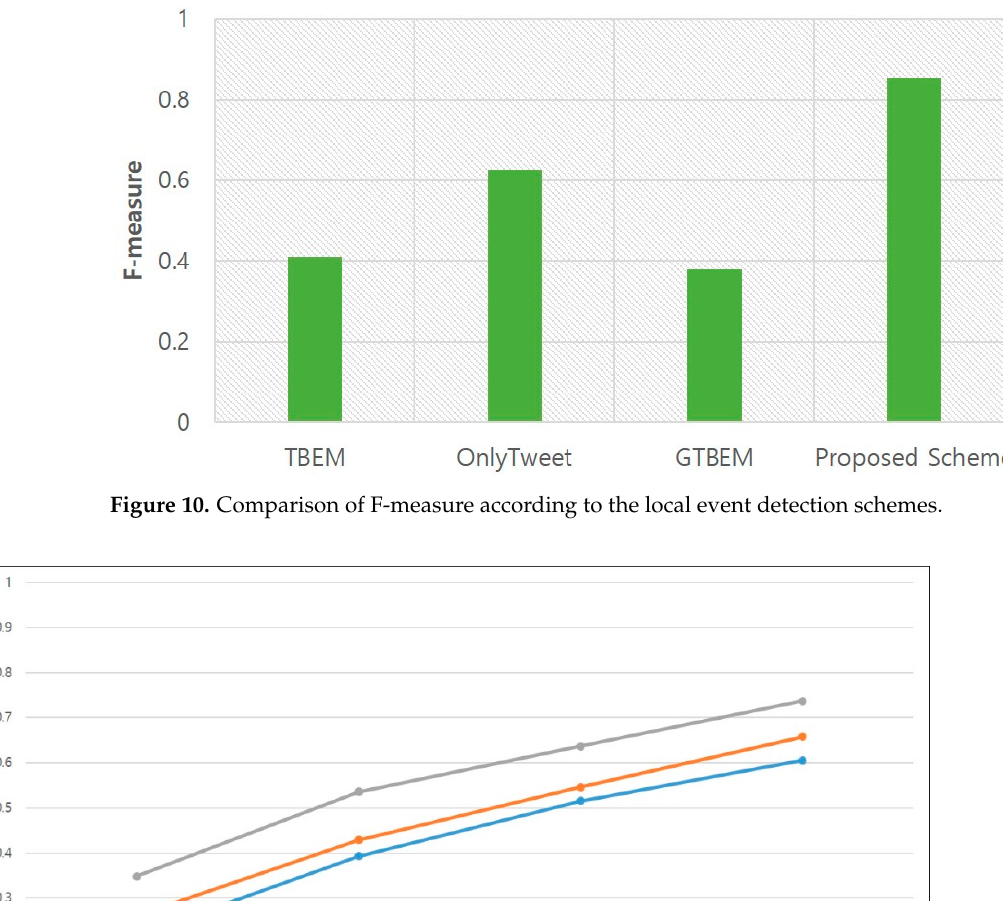
Figure 10. Comparison of F-measure according to the local event detection schemes.